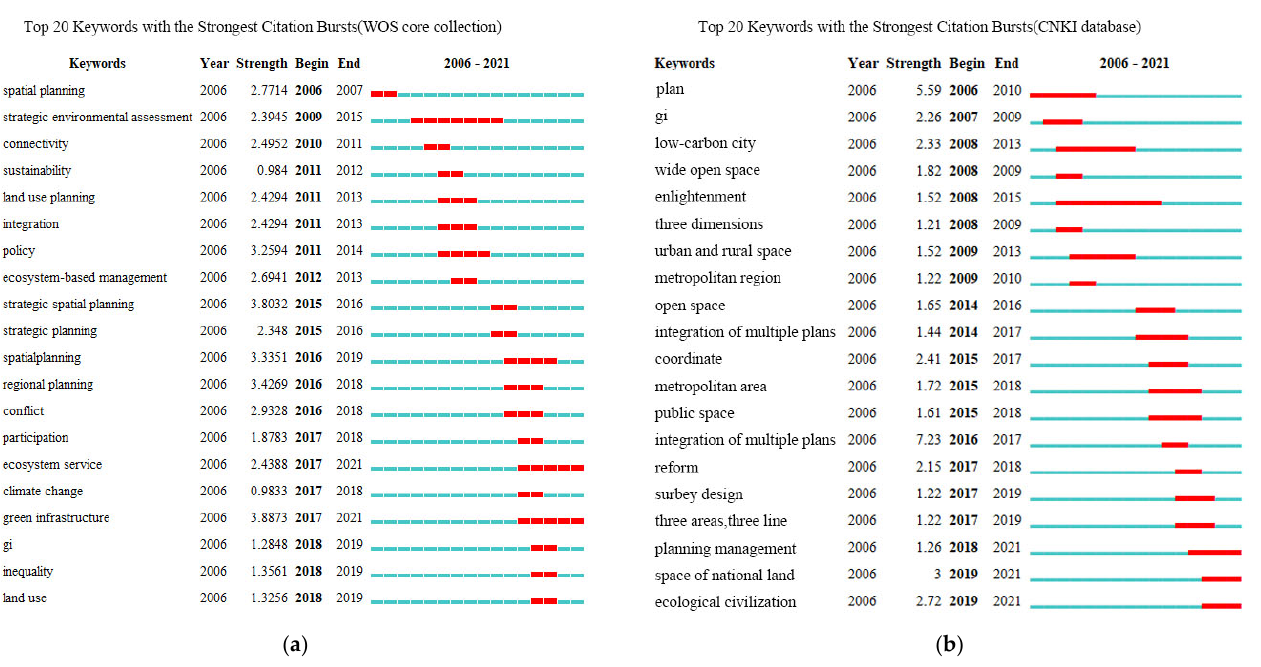
Figure 14. Visualization of the top twenty keywords with the strongest citation burst words for the WOSCC ( a ) and the CNKI database ( b ).